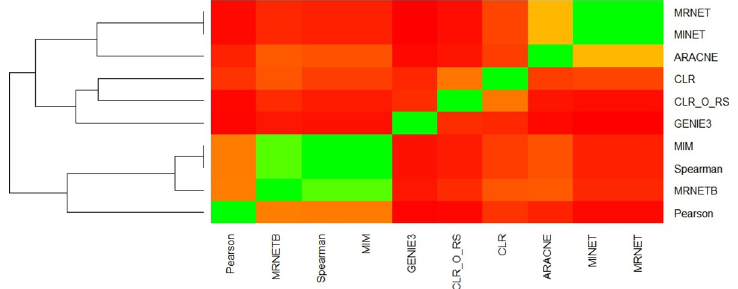
Fig 3. Comparisons of edge identity in networks. Overlap of identical edges is shown for all network inference methods by calculating the Jaccard similarity of edges (the ratio of intersection of edges/union of edges) when comparing two networks. Green indicates higher similarity and red lower similarity. Inference methods were clustered and the resulting dendogram is shown on the left. CLR_O_RS indicates the original CLR algorithm with resampling to distinguish it from the version of CLR used in the MINET